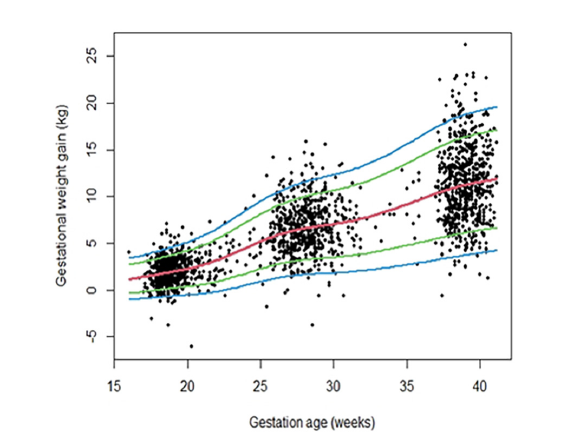
FIGURE2 Gestational weight gain (GWG) pattern in the primary analytic sample ( n = 640) of REVAMP cohort. Centile curves were generated for GWG using the